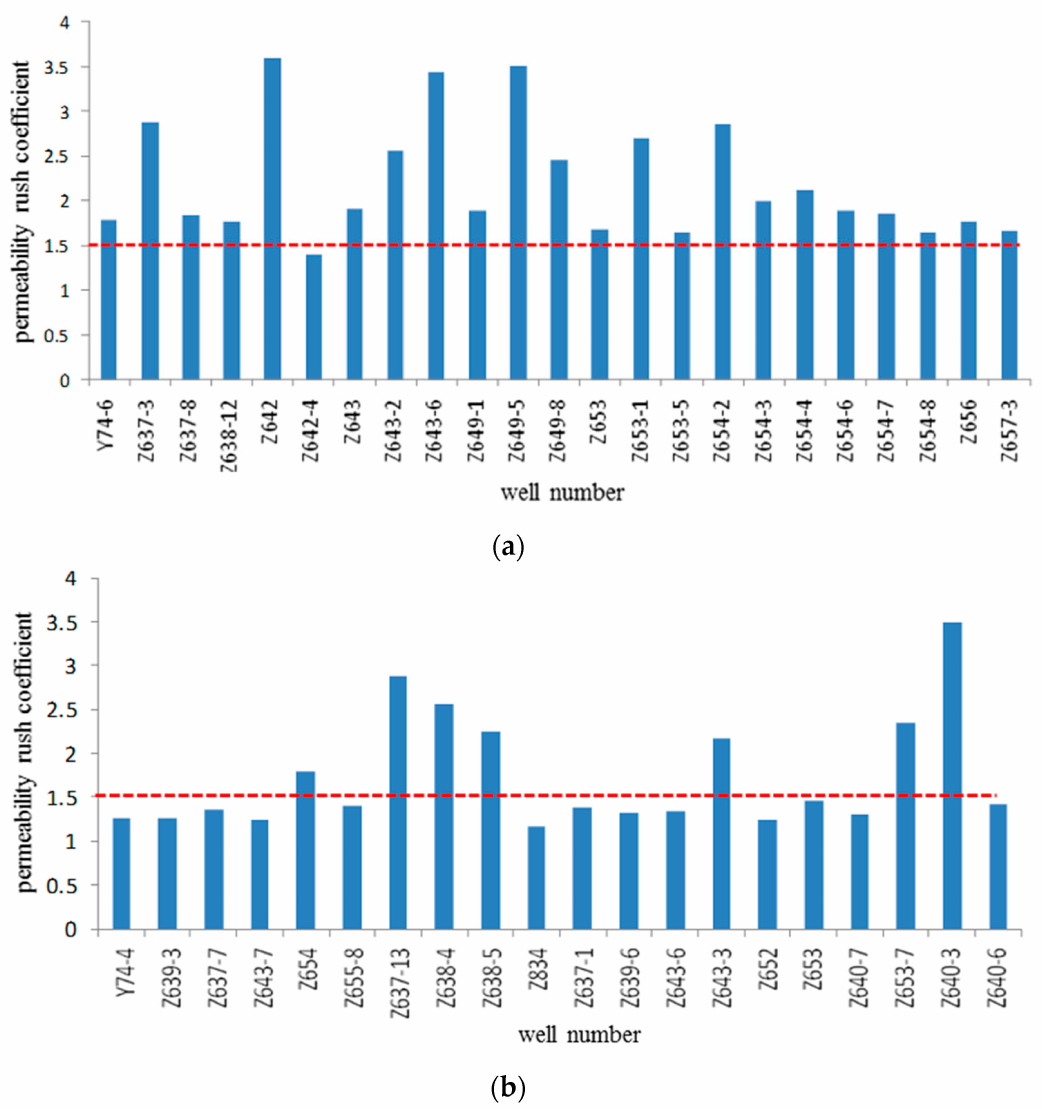
Figure 9. Distribution histogram of the permeability rush coefficient in wells with water channeling ( a ) and without water channeling ( b ). Red dotted line means the value of permeability rush coefficient is